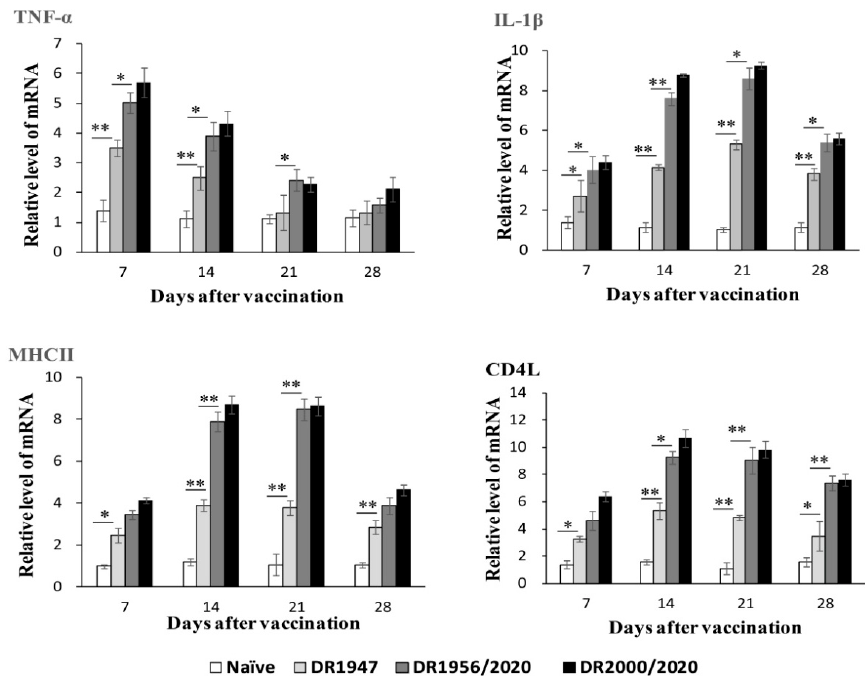
Figure 4. qRT-PCR analysis of the transcriptional response of immune-related genes in the head kidney of grass carp. Data are means for three independent assays and presented as the means ± SD. The comparison between the group DR1947 with the Naive group or the group DR1956/2020 was shown. Values that were significantly different from the control were indicated by asterisks (* p < 0.05, ** p < 0.01).